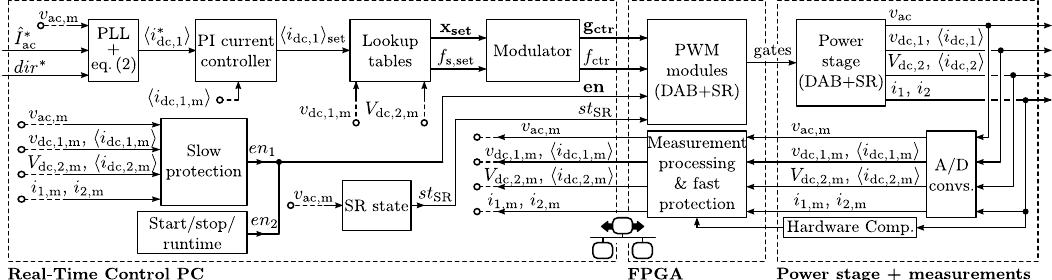
Figure 18. Control structure employed to control the switching-cycle averaged DAB input current (cid:104) i (cid:105) according to Equation dc,1